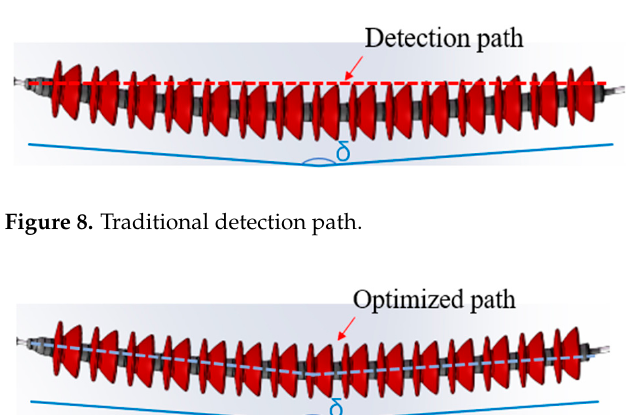
Figure 10. The electric field curve of the insulator under the effect of sag. It can be known through a simulation study that under the detection distance of 300 mm, when the “sag angle” δ is set to 165 and the detection path is straight without con- sidering sag, the electric field strength of the first to tenth insulator strings is higher than of the detection path considering sag, and natural sag in the middle of insulator strings has significant influences on the electric field distribution of the insulator string, with a maximum deviation of about 4.8%. Therefore, in the process of electric field detection with contactless devices, it is necessary to improve detection means, thus avoiding the natural drop in the middle of insulator strings affecting electric field detection results. Combined with the simulation results, it can be seen that the maximum error of the measured electric field distribution is reduced to 0.4% after optimizing the path. Therefore, the error caused by sag can be effectively reduced by increasing path interest points. 3. Electric Field Detection Method of Degraded Insulators Based on Sensitive Insula- tors The space electric field detection method of insulators can be applicable to different surface states; however, due to the attitude disturbance, path inclination, and other com- plex working conditions, if the traditional contactless electric field detection method is used for electric field detection, it will affect detection results. Therefore, it is necessary to improve the traditional detection method. 3.1. Criterion for Sensitive Insulators Assuming the insulator string is dry and free from pollution, with good insulation performance, infinite resistance, and no leakage conductivity considered, the insulator